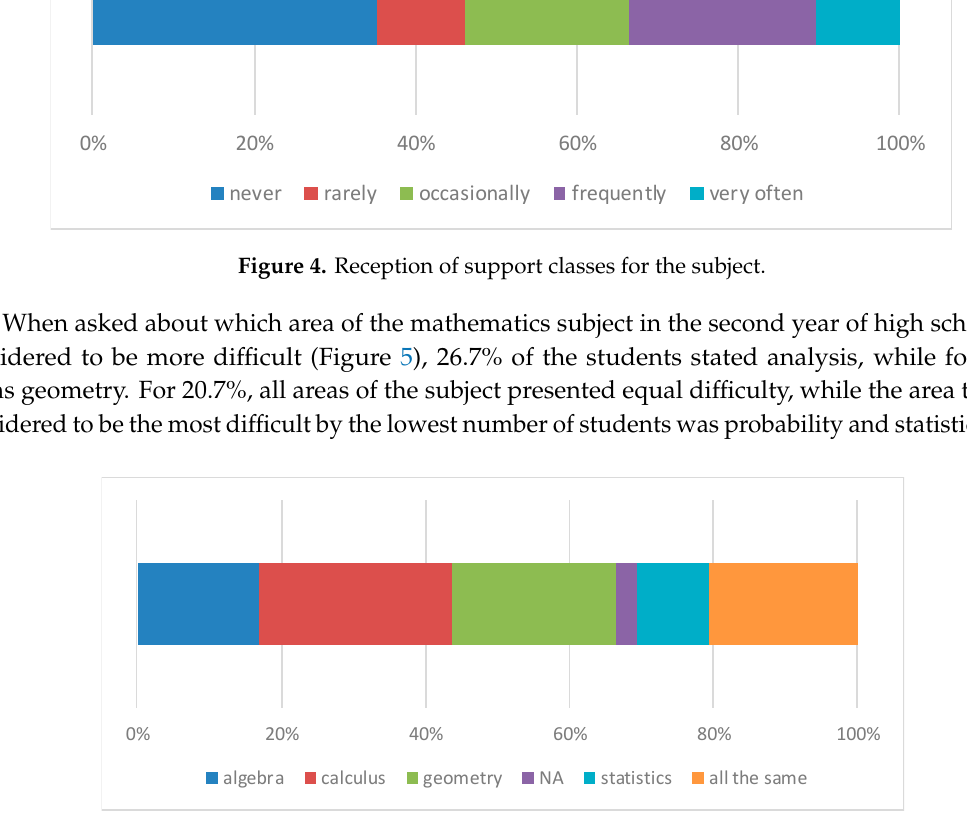
Figure 5. Areas of mathematics of the second year of the baccalaureate that are most difficult for students.